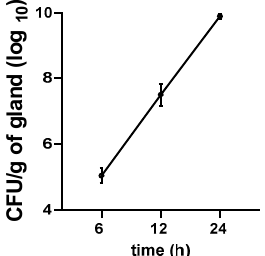
Figure 4. Growth kinetics of E. coli in the mouse mammary gland at 6, 12 and 24 h after the administration of 100 CFU through the teat channel. The bacterial loads for each time point were evaluated in 8 individual mammary glands (4 mice).Bars represent the mean ± standard deviation.